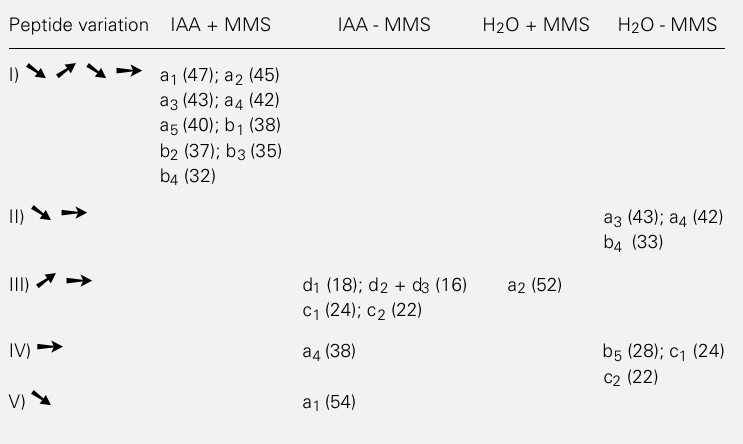
Table 1 - Changes in the relative content of some peptides during latex coagulation. The relative variation of each band was determined by densitometry and analyzed with CS9301PC software (Hitachi) using the less variant peak as standard. The estimated molecular mass (kDa) for each band is shown in parentheses. Samples were collected with iodoacetamide (IAA) or H 2 O and methyl methane thiosulfonate (MMS) was added (+ MMS) or not (- MMS) to the sample buffer. The orientation of the arrow shows the direction of change of relative amount of the peptide. Peptide variation IAA +